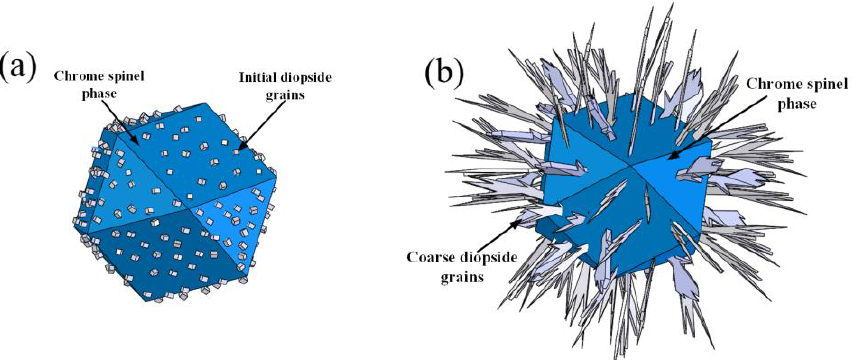
Figure 11. Schematic diagram of the diopside phase and magnesia chrome spinel phase (( a ) is the magnesia chrome spinel phase and diopside phase in the nucleation stage, ( b ) is the magnesia chrome spinel phase and diopside phase in the crystallization stage).